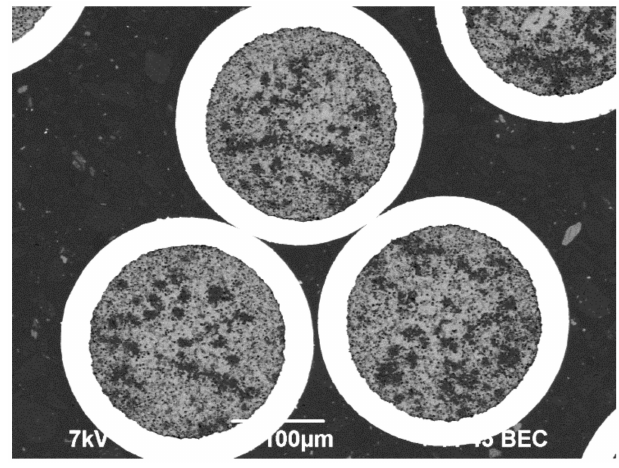
Figure 1. Cross-sections of the bimetallic wires. Scanning electron microscope (SEM).